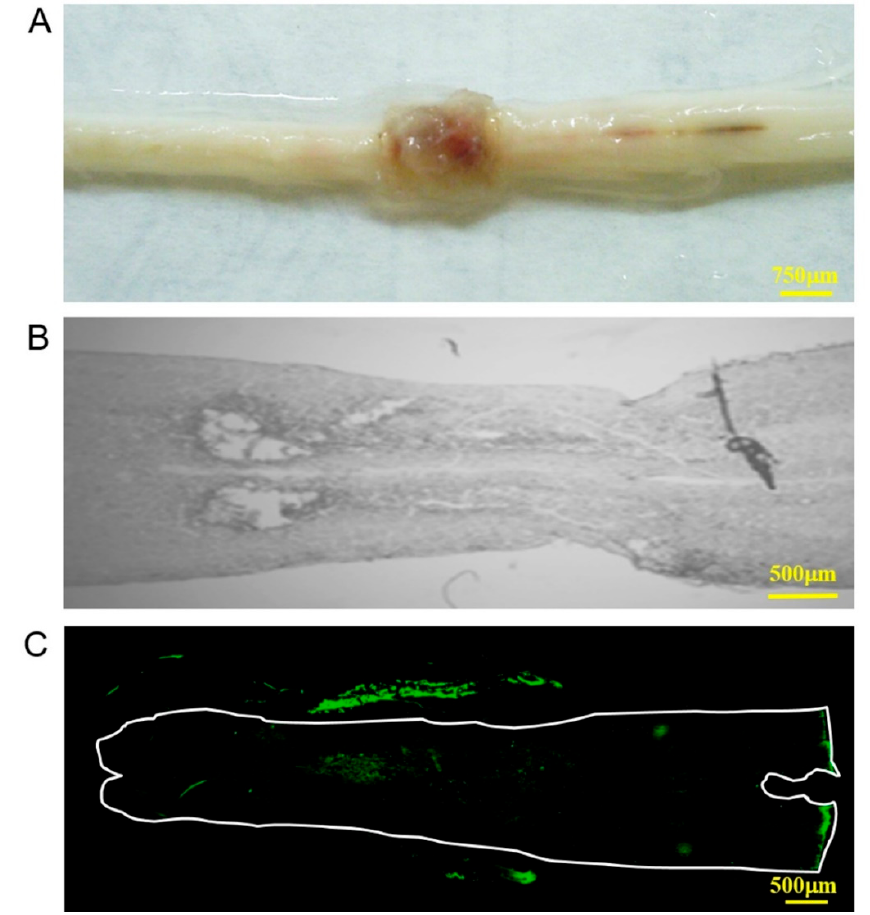
Figure 4. In vivo biocompatibility of the collagen sca ff old implanted in the T8 of spinal cord for 4 weeks. ( A , B ) Macroscopic appearance and observation under a visible light microscope, respectively; ( C ) expression of anti-collagen antibody observed using immunofluorescence